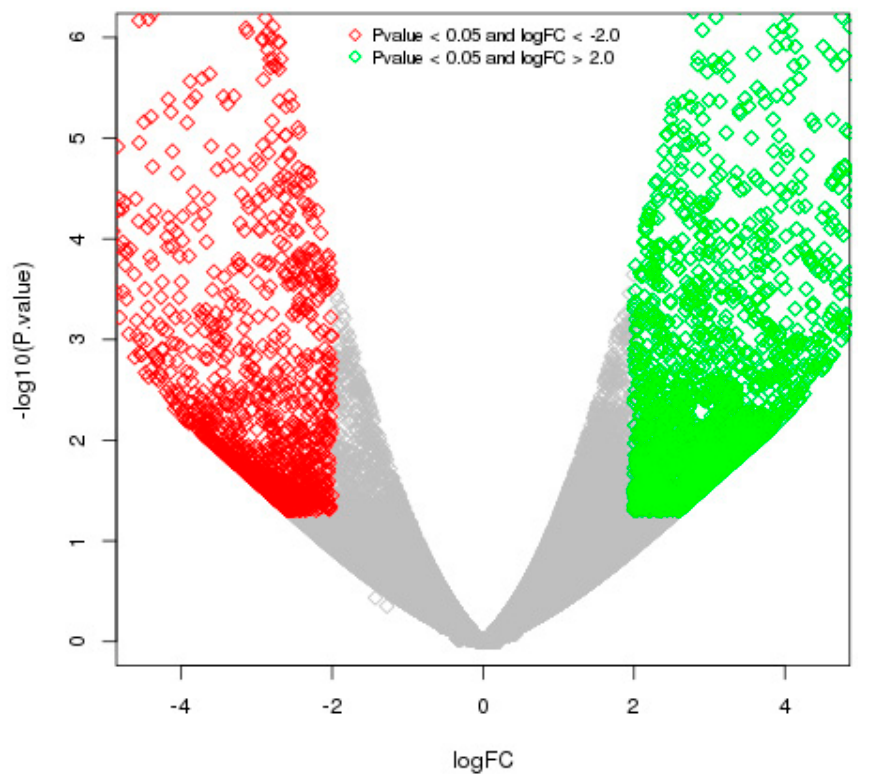
Figure 2. A volcano plot showing the distribution of DEGs among resistant and susceptible genotypes of wheat upon T. indica infection. DESeq analysis was performed to show the distribution of DEGs. Green spots correspond to genes with p -value < 0.05 and logFC > 2, while red spots correspond to genes with p -value < 0.05 and logFC < − 2.